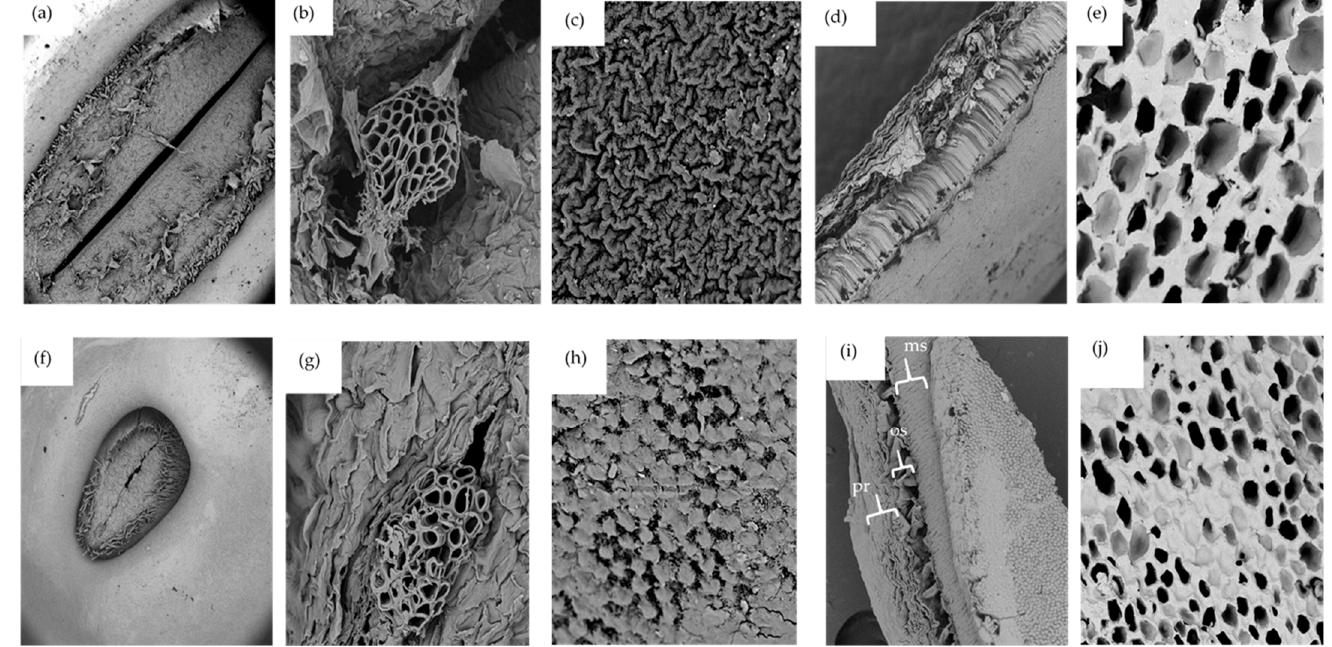
Figure 2. SEM micrographs of L. albus : ( a ) hilum (mag 175×), ( b ) micropyle (mag 2300×), ( c ) external surface of the seed coat (mag 3500×), ( d ) transversal cut of seed coat (mag 500×), ( e ) transversal cut of cotyledon (mag 1000×). SEM micrographs of L. angustifolius : ( f ) hilum (mag 175×), ( g ) micropyle (mag 2300×), ( h ) external surface of the seed coat (mag 3500×), ( i ) transversal cut of seed coat (mag 500×), ( j ) transversal cut of cotyledon (mag 1000×). Acceleration voltage 10 kV; ms: macrosclereids, os: osteosclereids, pr: paranchyma.